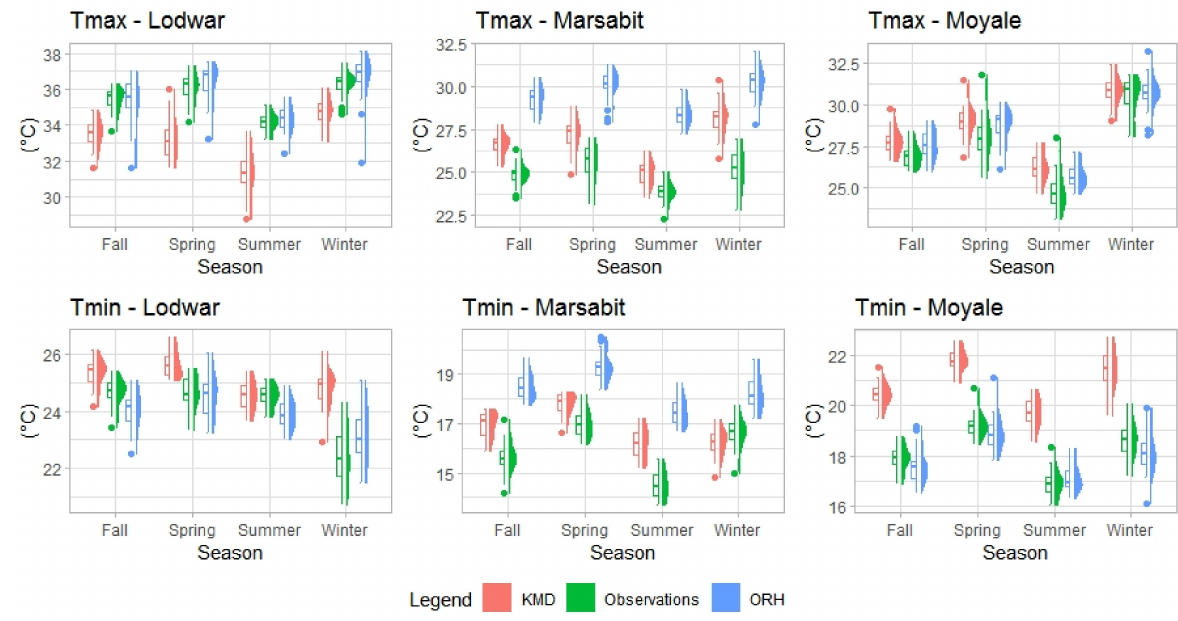
Figure 6. Seasonal boxplot of the observations, the KMD and the ORH T MIN and T MAX datasets for the selected land-based meteorological stations for the period 1983–2014. Next to the boxplots are the seasonal temperature density